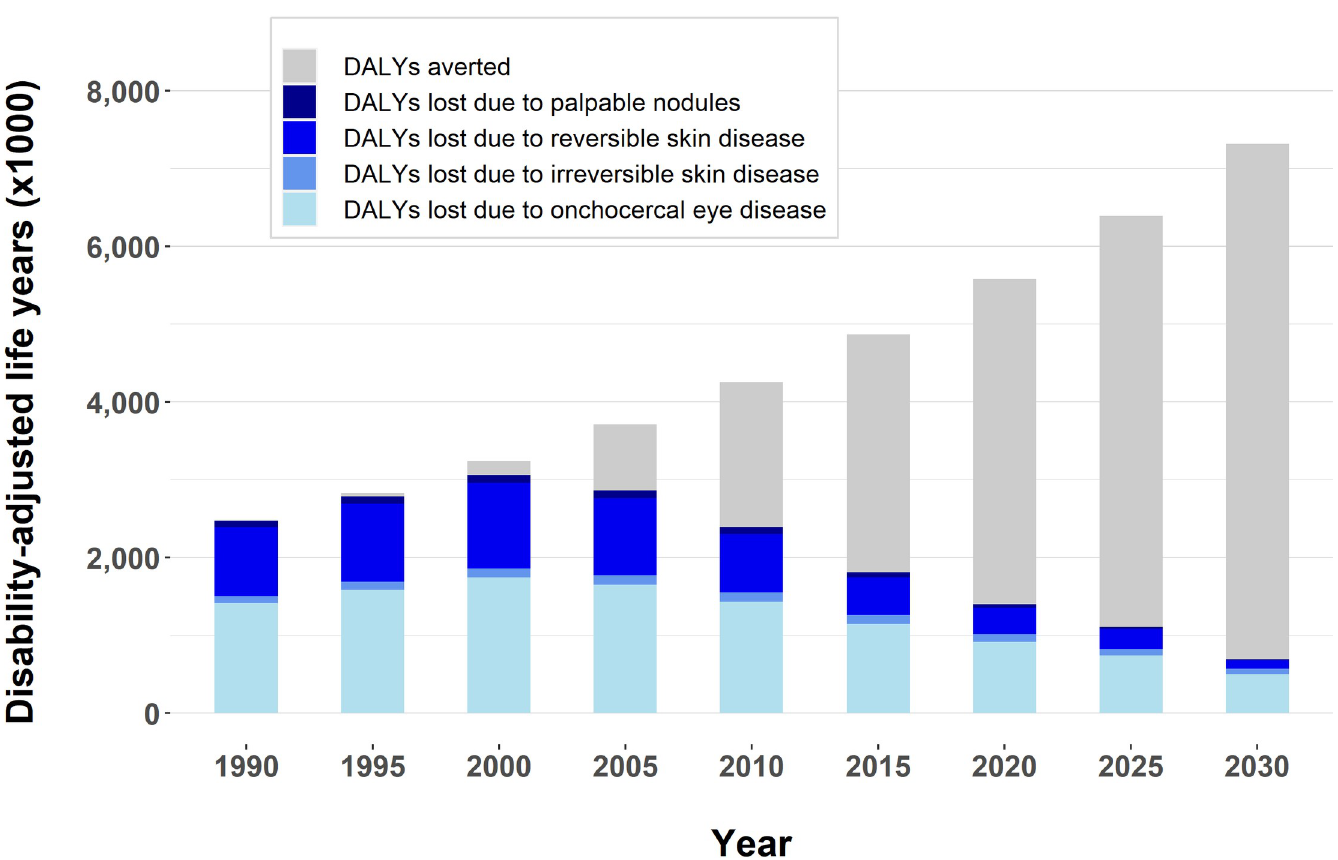
Fig 1. Total number of disability-adjusted life years (DALYs) lost and averted due to onchocerciasis from 1990 to 2030 in countries formerly covered by the African Programme for Onchocerciasis Control. DALYs are expressed in thousands (x1000). The total height of the blue part of the bars represents the estimated total number of DALYs lost, with different intensities of blue representing four subcategories of onchocercal morbidity (see legend). The total height of the bars (blue plus grey) represents the DALYs lost in a counterfactual scenario without large-scale MDA. The light grey part of each bar therefore represents the annual number of DALYs averted by